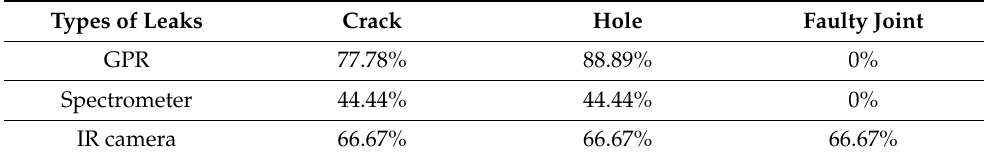
Table 10. Effect of types of leaks on leak